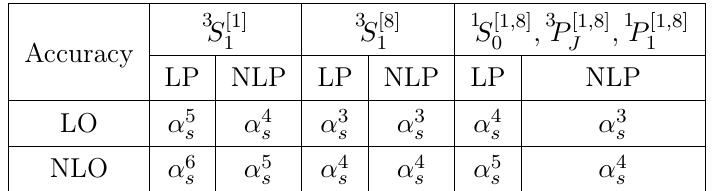
Table 2 . The first (cid:11) orders needed in the SDCs for both LP and NLP in P s in their hadroproduction in order to achieve the LO and NLO QCD accuracies. NNLO respectively. 1 Therefore, even with a full NNLO calculation at